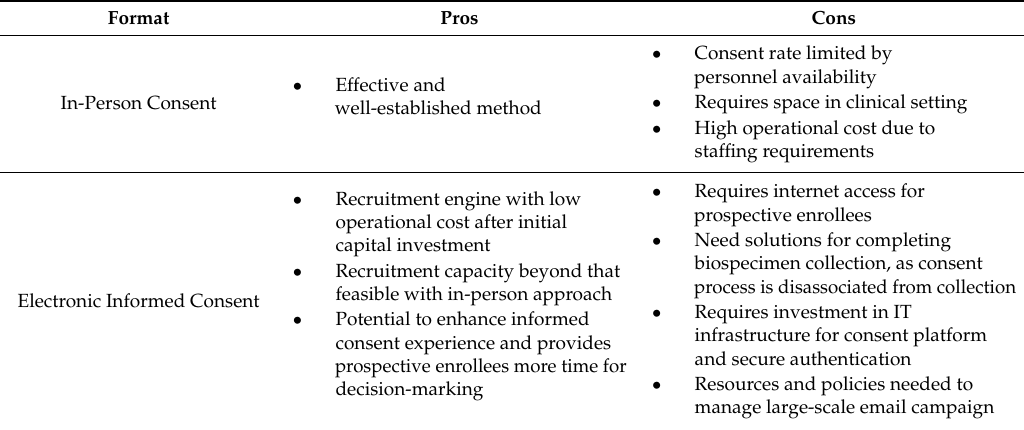
Table 3. Pros and cons of in-person vs. electronic informed consent.